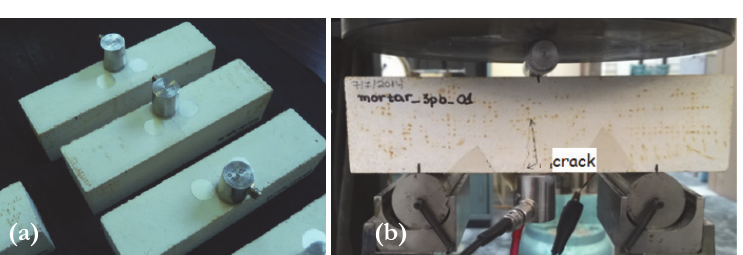
Figure 6: (a) The position of the acoustic sensor; (b) the experimental set up- and the initiation of the crack for a typical test with specimen made of mortar.